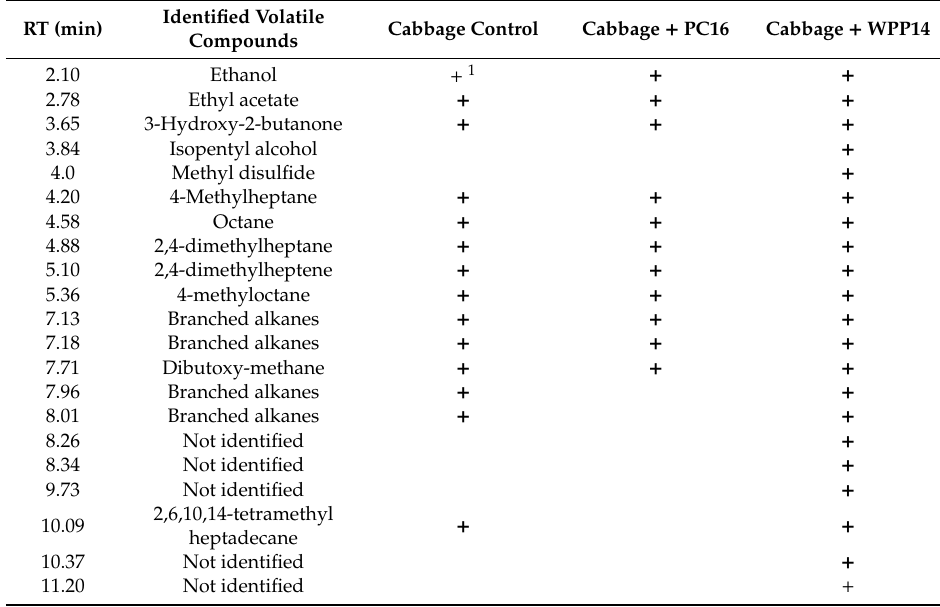
Table 2. VOCs collected from the headspace of cabbage samples inoculated with PC16 or WPP14 and the corresponding control (DDW), as identified by GC-MS.